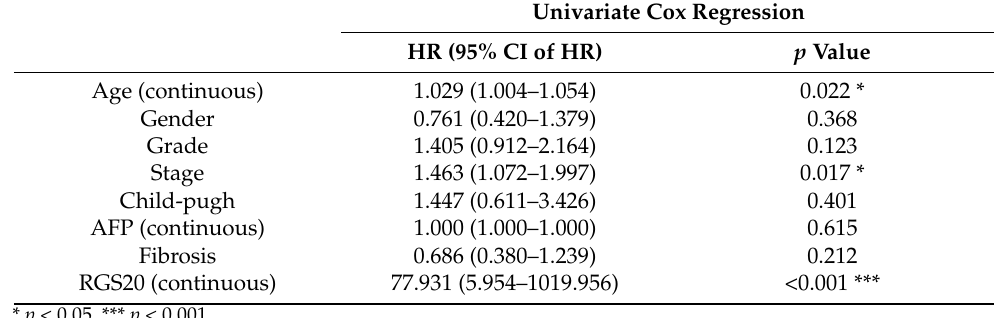
Table 2. Univariate survival prediction of RGS20 expression and the clinical factors using TCGA data.